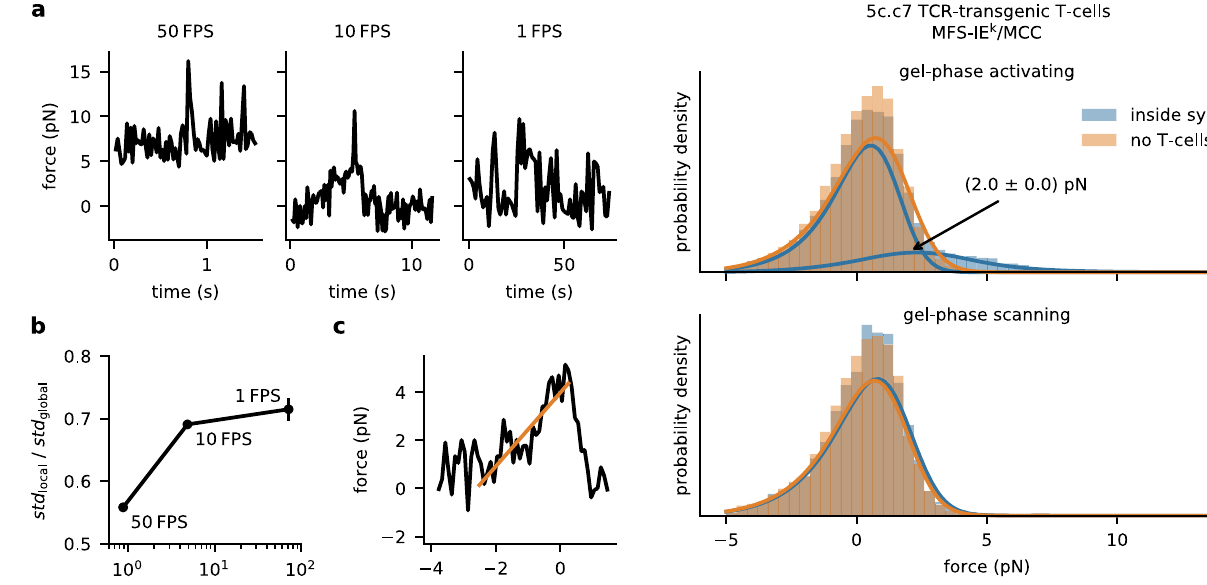
Fig. 5 Single-molecule pulling forces exerted via single TCRs on the pMHC-functionalized molecular force sensor. Single-molecule analysis of MFS – IE k /MCC on gel-phase SLBs recorded under activating (top) or scanning conditions (bottom), using antigen-experienced 5c.c7 TCR- transgenic T-cells. We observed a signi fi cant high force peak at 2.0 ± 0.0 pN for the activating case amounting to 24% of all events, which was no longer detectable under scanning conditions. n = 18,763 (770 movies) for activated T-cells, n = 14,991 (205 movies) for stimulatory SLBs without T-cells, n = 8646 (348 movies) for scanning T-cells, n = 5120 (106 movies) for non-stimulatory SLBs without